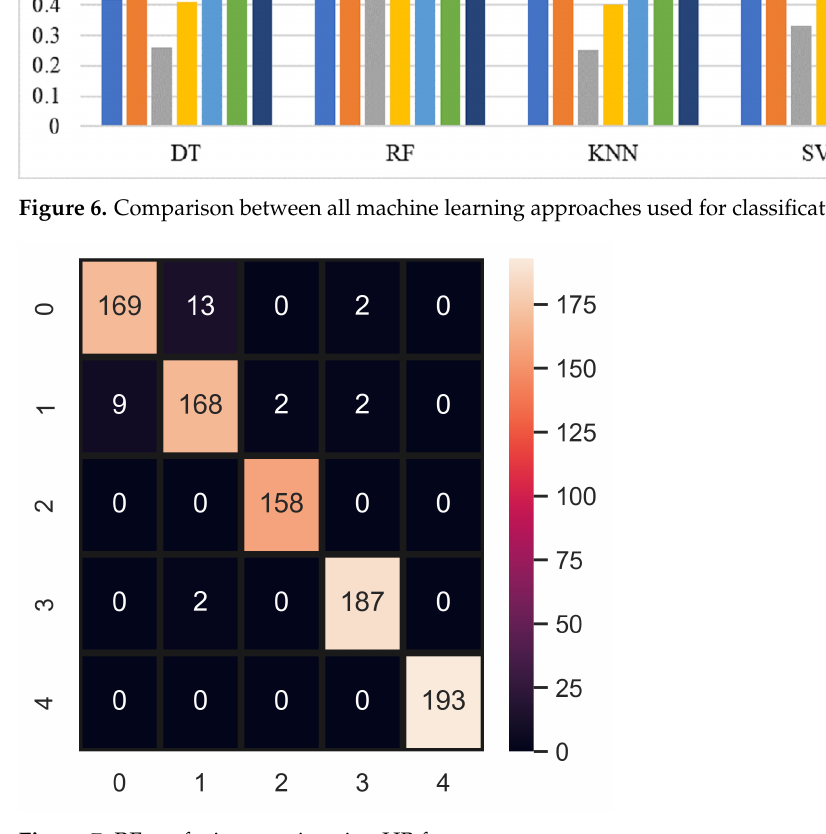
Figure 7. RF confusion matrix using HB